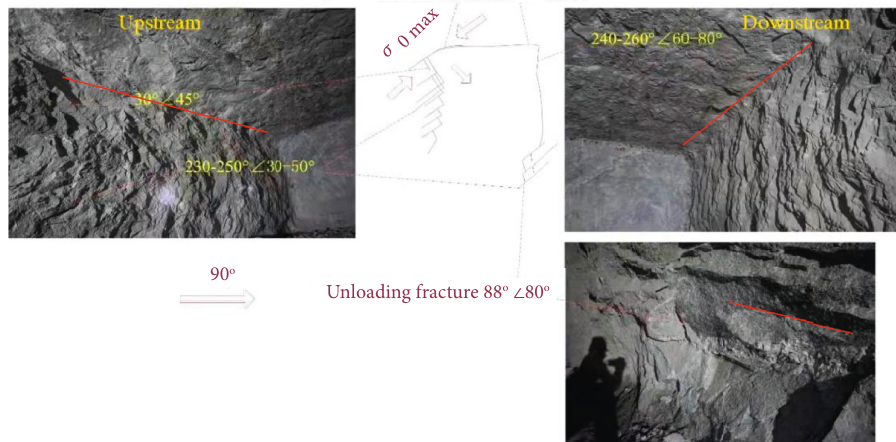
Figure 22: Deformation and failure of the surrounding rock in the K0 +010.00–K0 +013m of the pilot